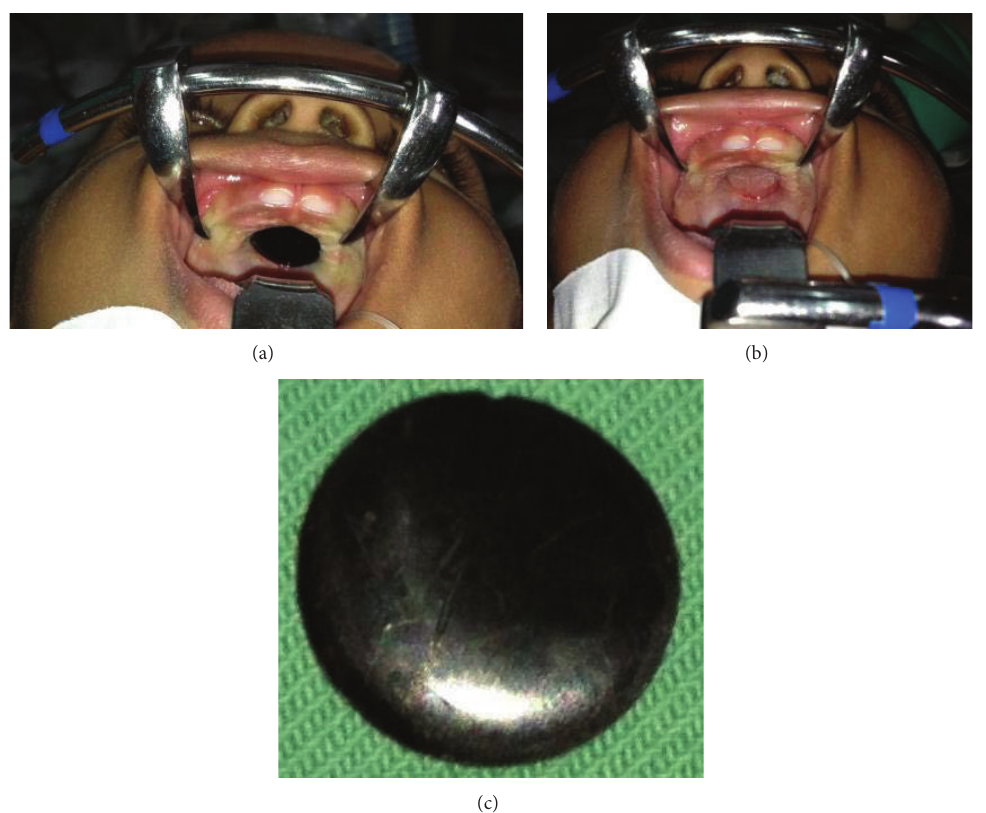
Figure 1: (a) The black foreign body embedded on the hard palate. (b) The foreign body was detached. (c) The extracted foreign body.